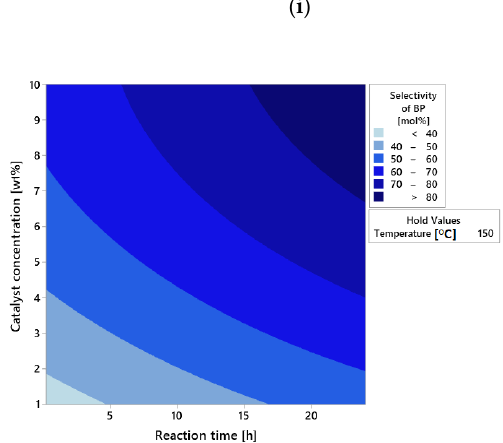
Figure 11. The influence of transformation process parameters on β -pinene selectivity at: time: Figure 11. The in fl uence of transformation process parameters on β -pinene selectivity. ( a ) 0.25 h, ( b ) 12.125 h, and ( c ) 25 h, concentration: ( d ) 1 wt%, ( e ) 5.5 wt%, and ( f ) 10 wt%, and temperature: ( g ) 80 ◦ C, ( h ) 115 ◦ C and ( i ) 150 ◦ C.